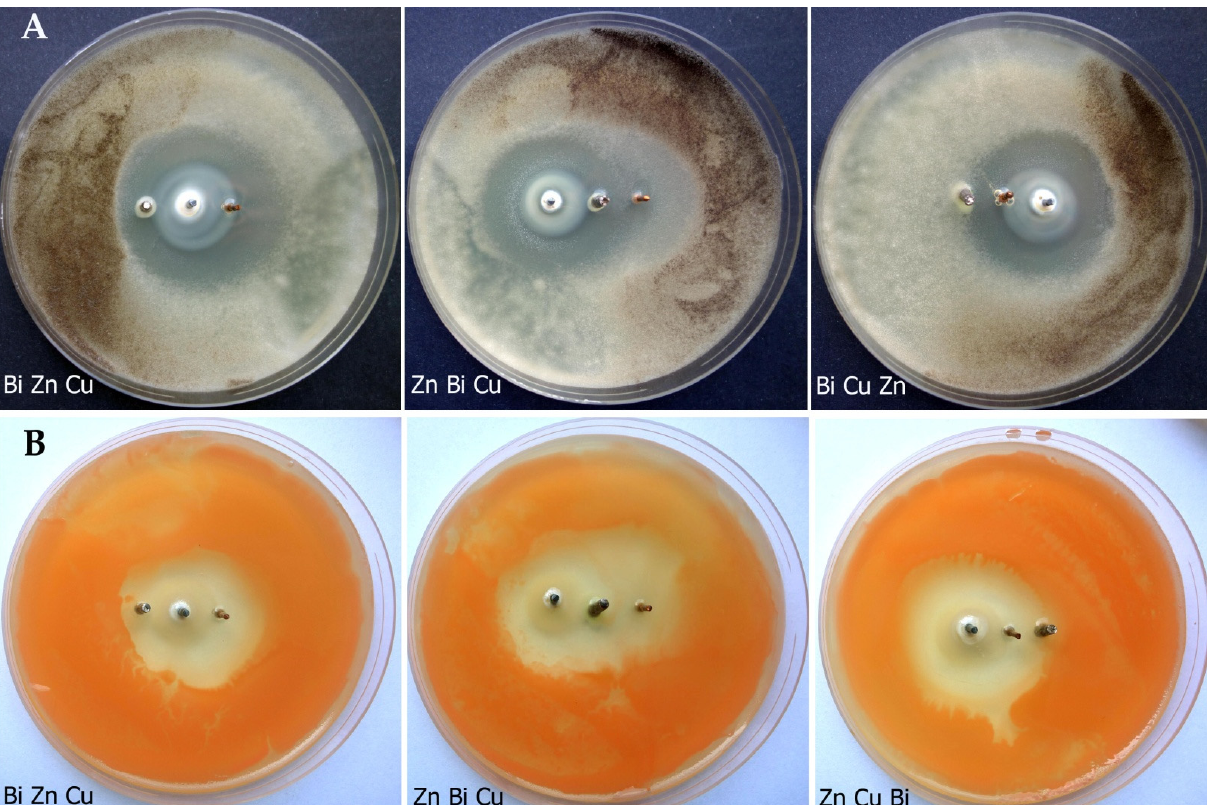
Figure 6. Influence of electrode configurations on the inhibition zones. ( A )— Aspergillus tubingensis , ( B )— Rhodotorula mucilaginosa , photo A. Chlebicki.